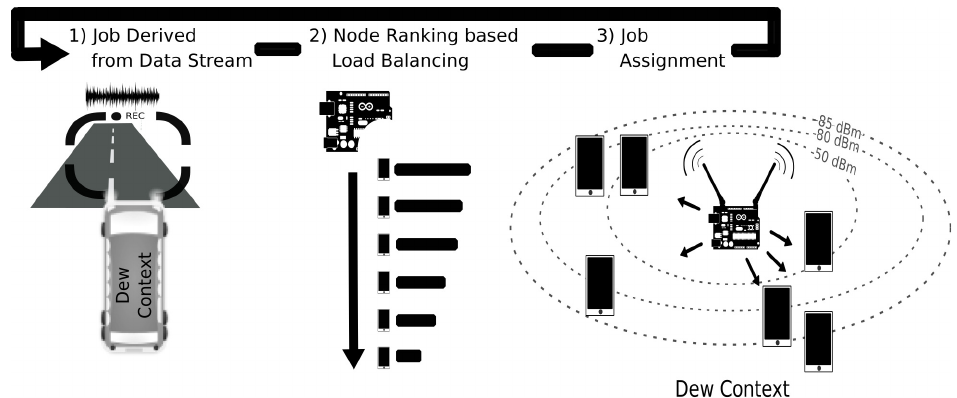
Figure 1. The dew